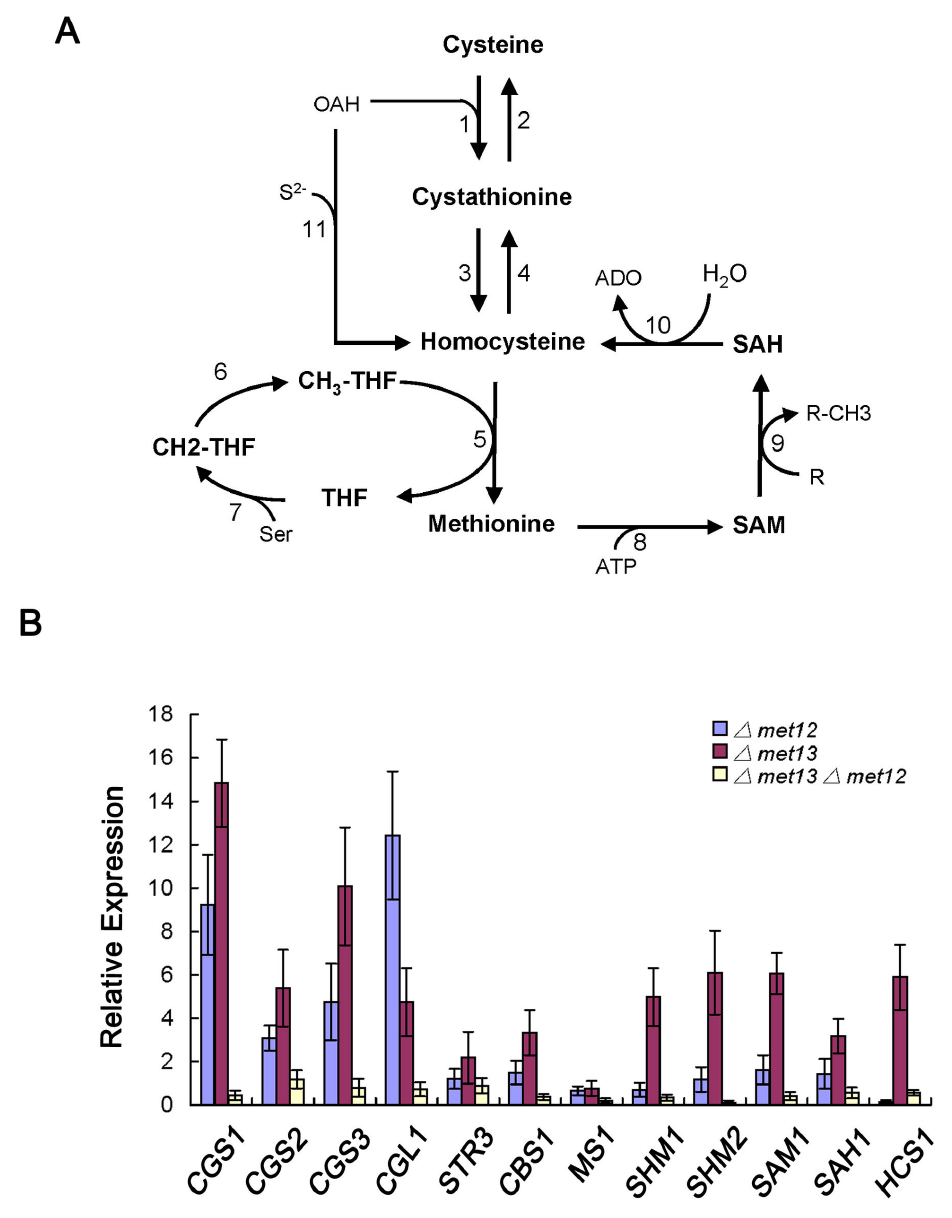
Figure 9. The predicted pathway for methionine biosynthesis in M. oryzae and expression of several genes involved in the pathway in Δmet13 , Δmet12 and Δmet13Δmet12 mutants. ( A ) An outline of methionine metabolism in M . oryzae . The predicted genes and corresponding enzymes: 1. CGS1 (MGG_03583), CGS2 (MGG_09292) and CGS3 (MGG_04764) - cystathionine γ- synthase; 2. CGL1 (MGG_10380) - cystathionine γ-lyase; 3. CBL1 / STR3 (MGG_07074) - cystathionine β-lyase; 4. CBS1 (MGG_07384) - cystathionine β-synthase; 5. MS1 (MGG_06712) - methionine synthase; 6. MET13 (MGG_01728) and MET12 (MGG_08171) - methylenetetrahydrofolate reductase (MTHFR); 7. SHM1 (MGG_13781) and SHM2 (MGG_00923) - serine hydroxymethyltransferase; 8. SAM1 (MGG_00383) - S-adenosyl-methionine synthase; 9. various methyltransferases; 10. SAH1 (MGG_05155) - S-adenosyl homocysteine hydrolase; 11. HCS1 (MGG_07195) - homocysteine synthase. SAM: S-adenosyl methionine; SAH: S-adenosyl homocysteine; OAH: O-acetylhomoserine; ADO: Adenosine; Ser: Serine; R: any methylacceptor substrate. ( B ) Expression of the predicted genes coding enzymes involved in methionine metabolism in the Δmet13 , Δmet12 and Δmet13Δmet12 mutants measured by quantitative reverse-transcription polymerase chain reaction (qRT-PCR). The abundance of the gene transcripts was calculated relative to endogenous control (β-tubulin gene) using the 2 –ΔΔCT method. Error bars represent the standard deviation. doi: 10.1371/journal.pone.0076914.g009 PLOS ONE |